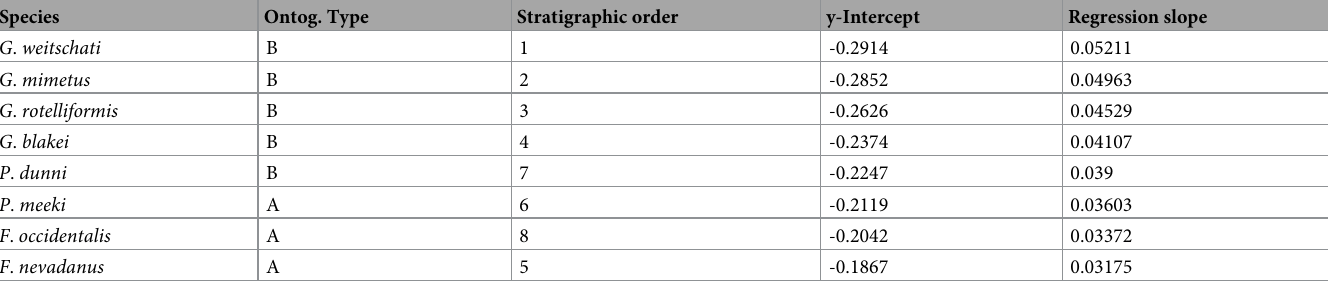
Table 2. Intercept and slopes of linear model of fitted shape values on centroid size. Species Ontog.